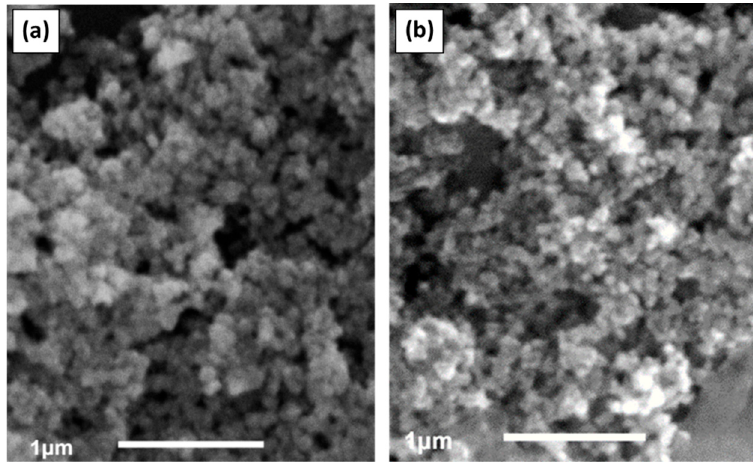
Figure 2. SEM images of as-prepared samples ( a ) CdS and ( b ) ZnS.